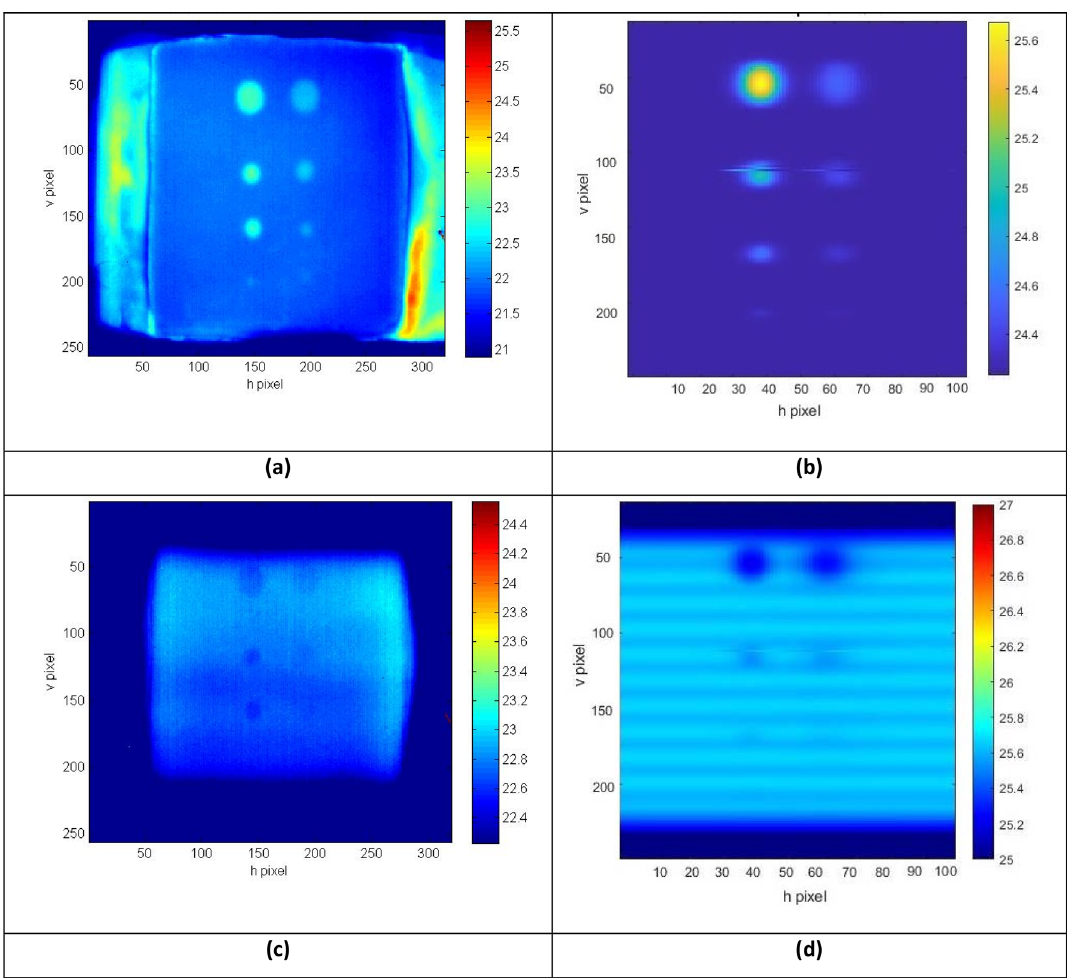
numerical ( d ) SMArt thermography after 468.8 s from the end of heating time t of 240 h